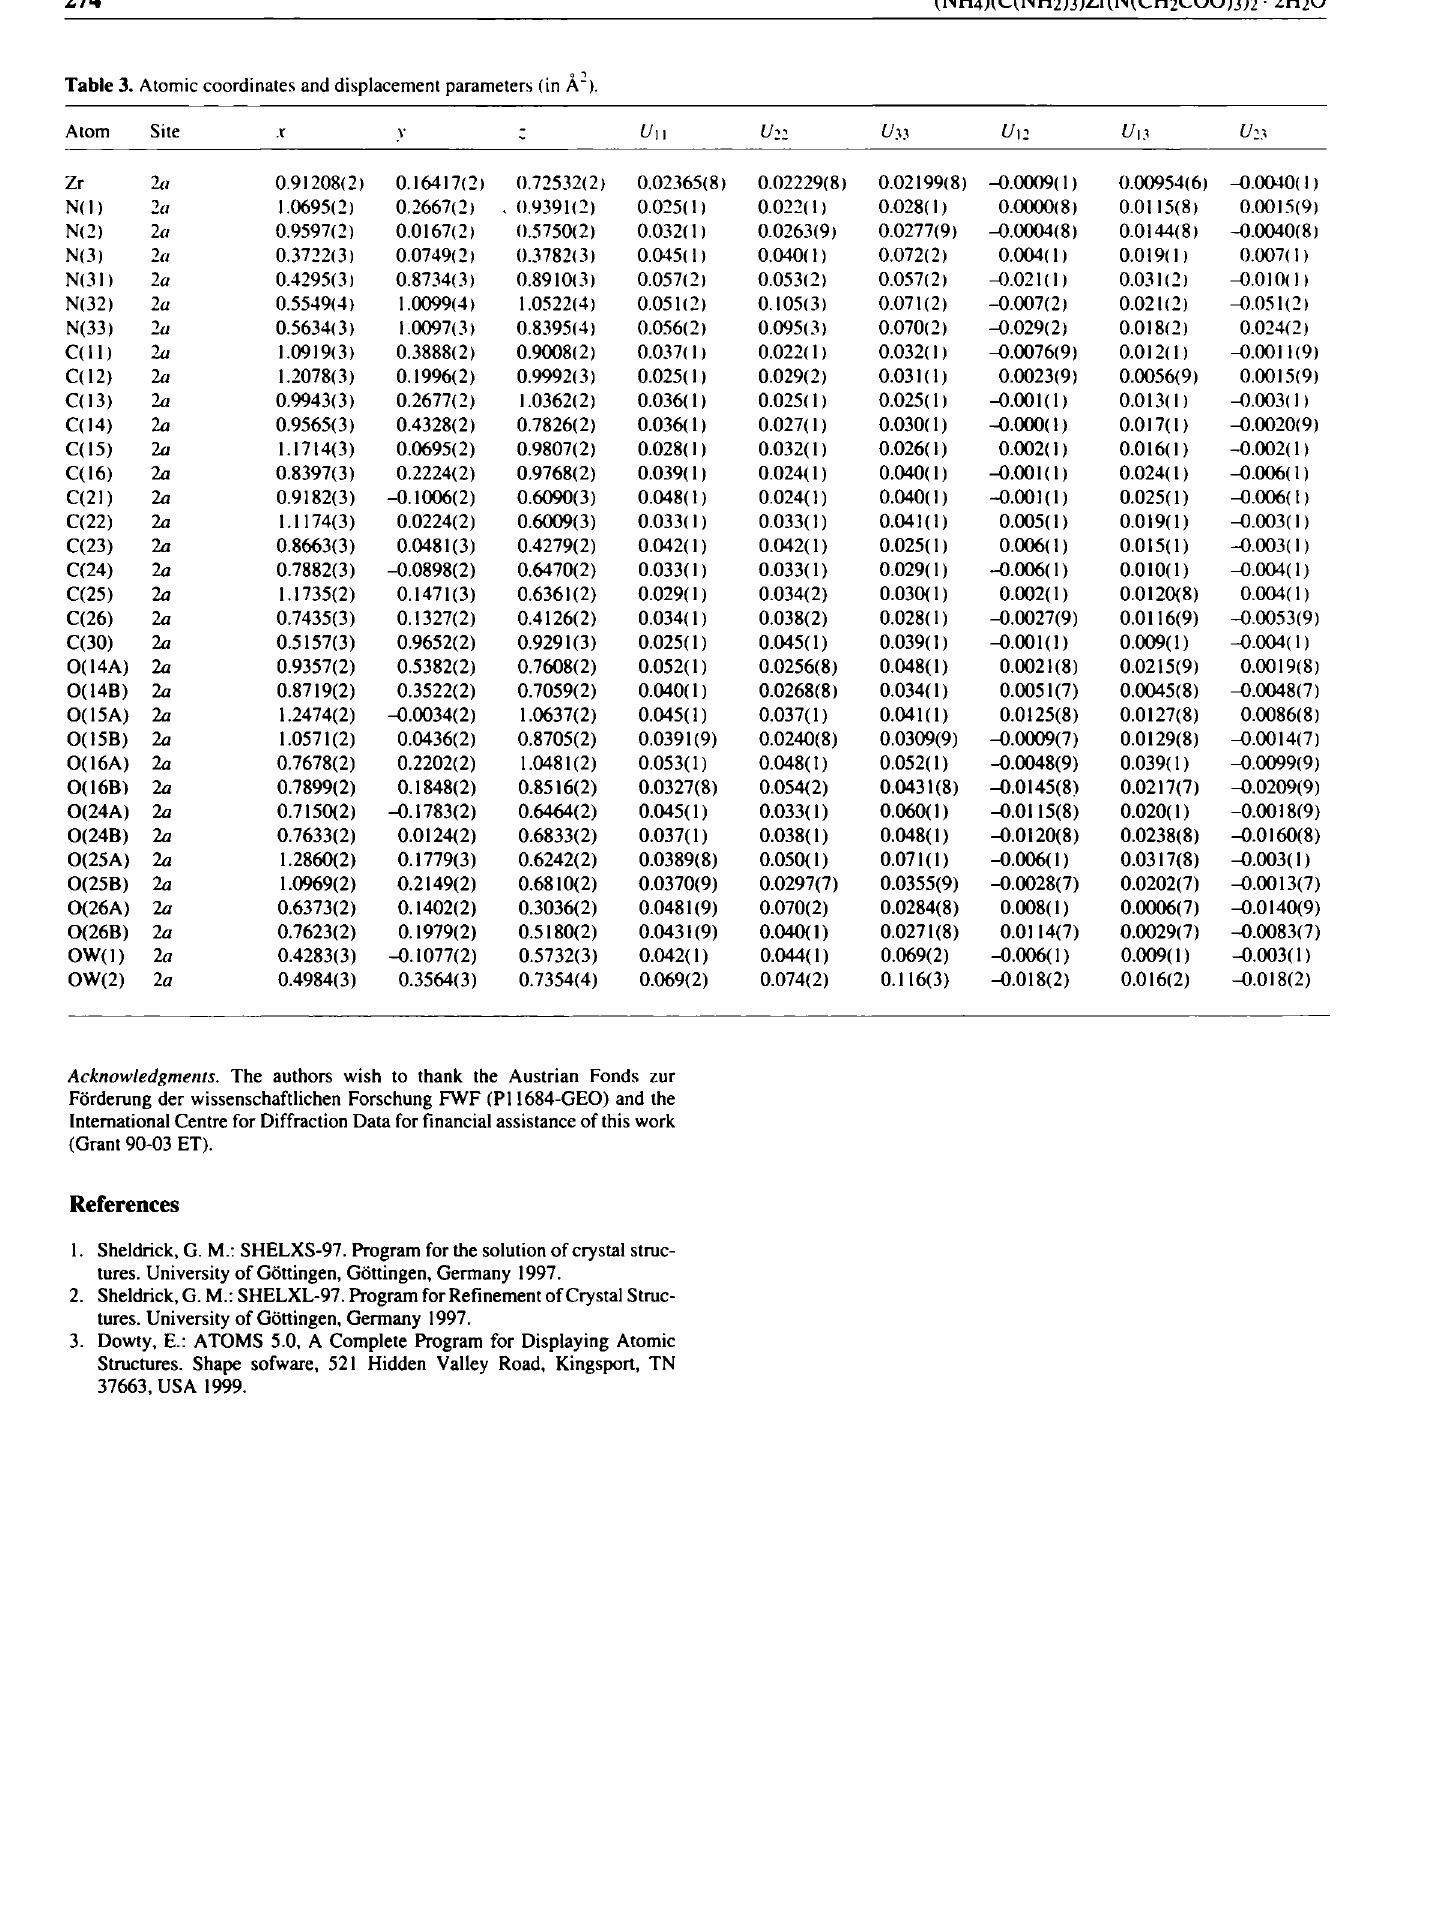
Table 3. Atomic coordinates and displacement parameters (in A"). Atom